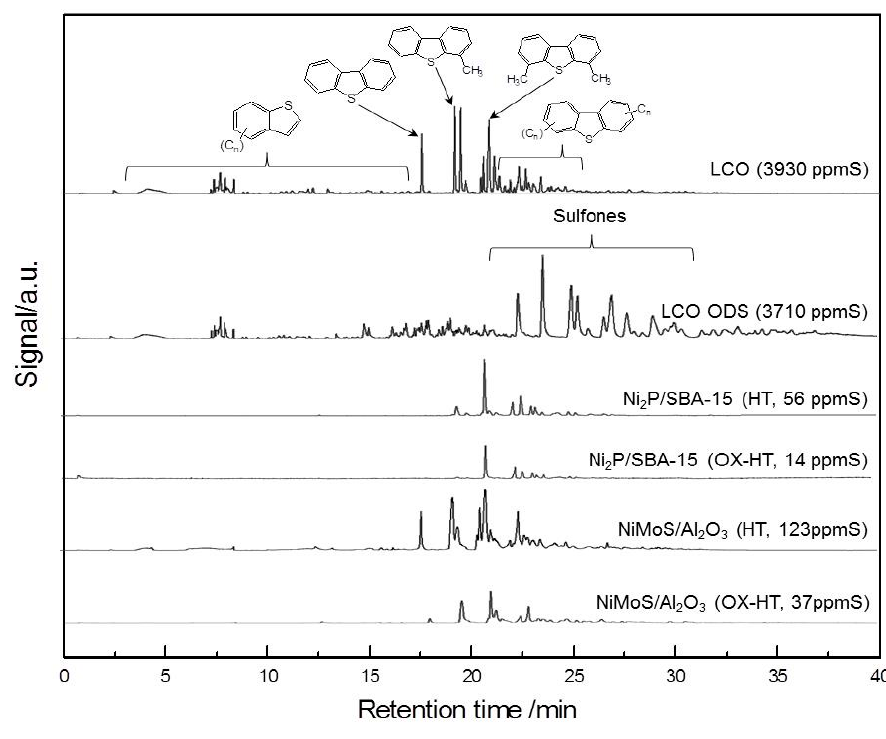
Figure 4. HDS and HDN conversions over Ni 2 P/SBA ‐ 15 and Ni ‐ Mo ‐ S at 3.0 MPa and 623 K.